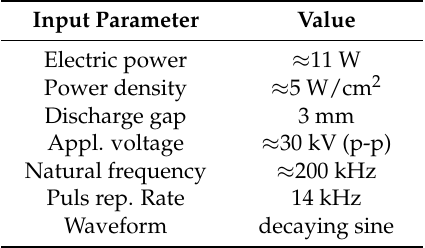
Figure 1. Experimental Setup for plasma treatment of regular tap water. Table 1. Input parameters for experimental setup.